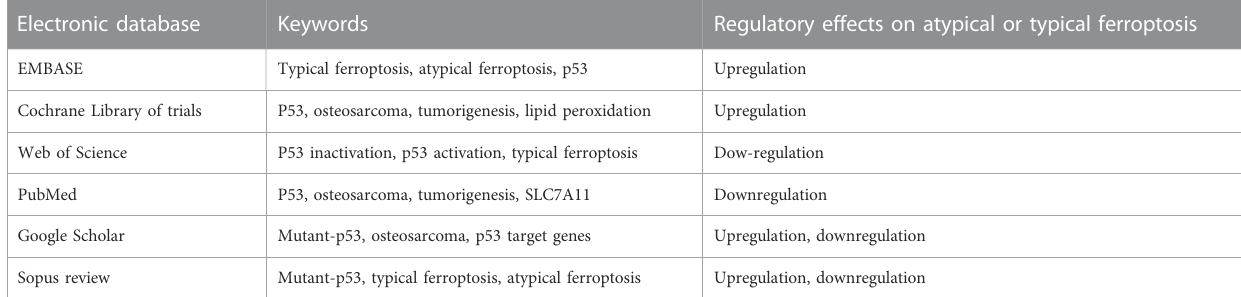
TABLE 1 Search strategy: Electronic databases where literature search was done and the